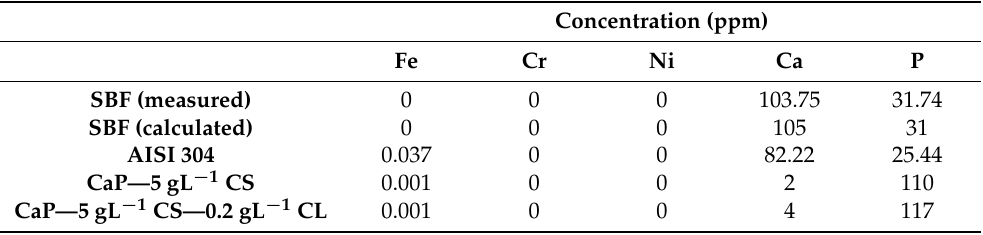
Table 3. Concentration of ions in the SBF solution after 3-weeks of aging. For comparison, the concentration of Ca and P ions in the as-prepared SBF solution was reported (SBF measured). The mean standard deviation was 0.7%. (SBF calculated is the expected concentration determined from the quantity of the salts used to prepare the solution).